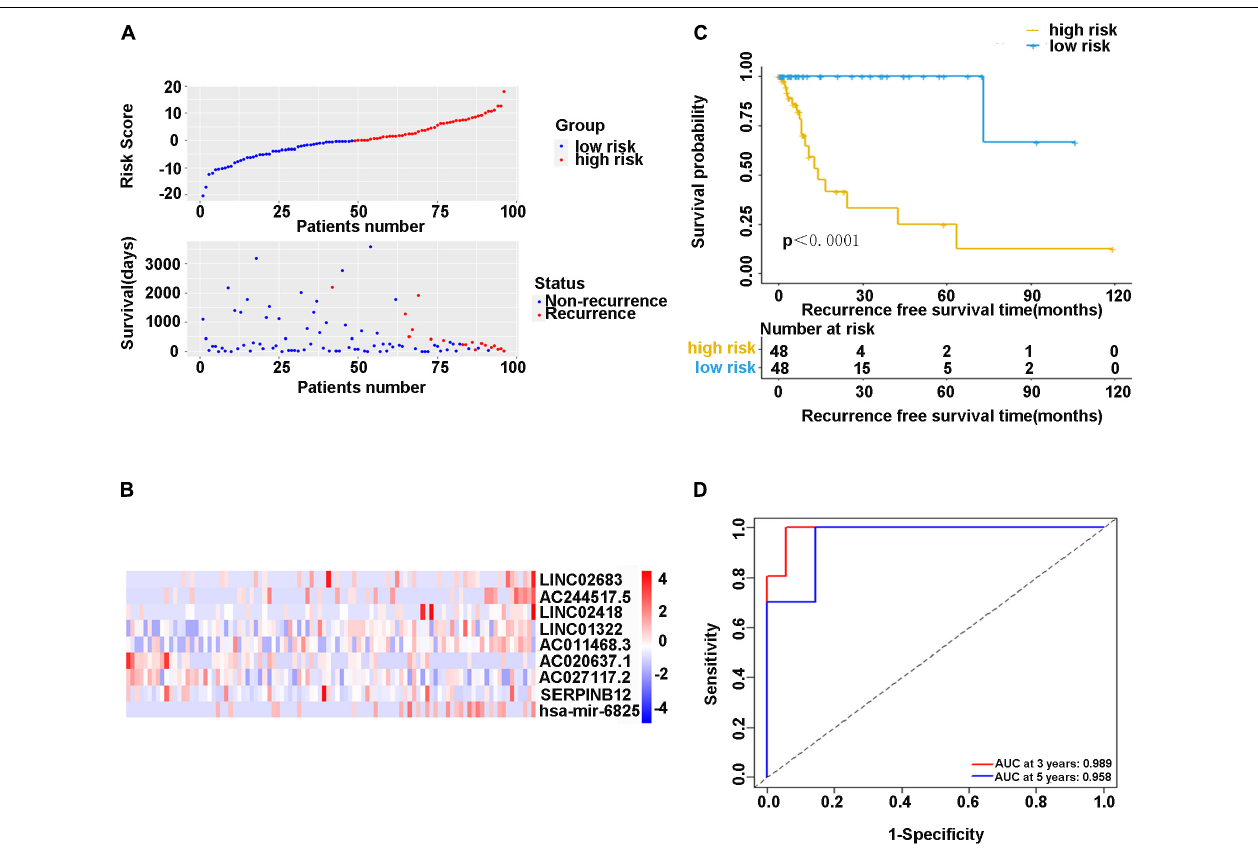
FIGURE 4 | (A) Scatter diagram of the risk score and survival status of patients with stage I-IIIA LUSC in the training cohort. (B) The heatmap of nine-gene expression profiles for predicting recurrence risk model. (C) Kaplan-Meier plot showed significance between high-risk and low-risk patients in RFS by the prognostic model ( P < 0.05). (D) The ROC curve analysis for the recurrence risk model. ROC, receiver operating characteristic; AUC, area under the ROC